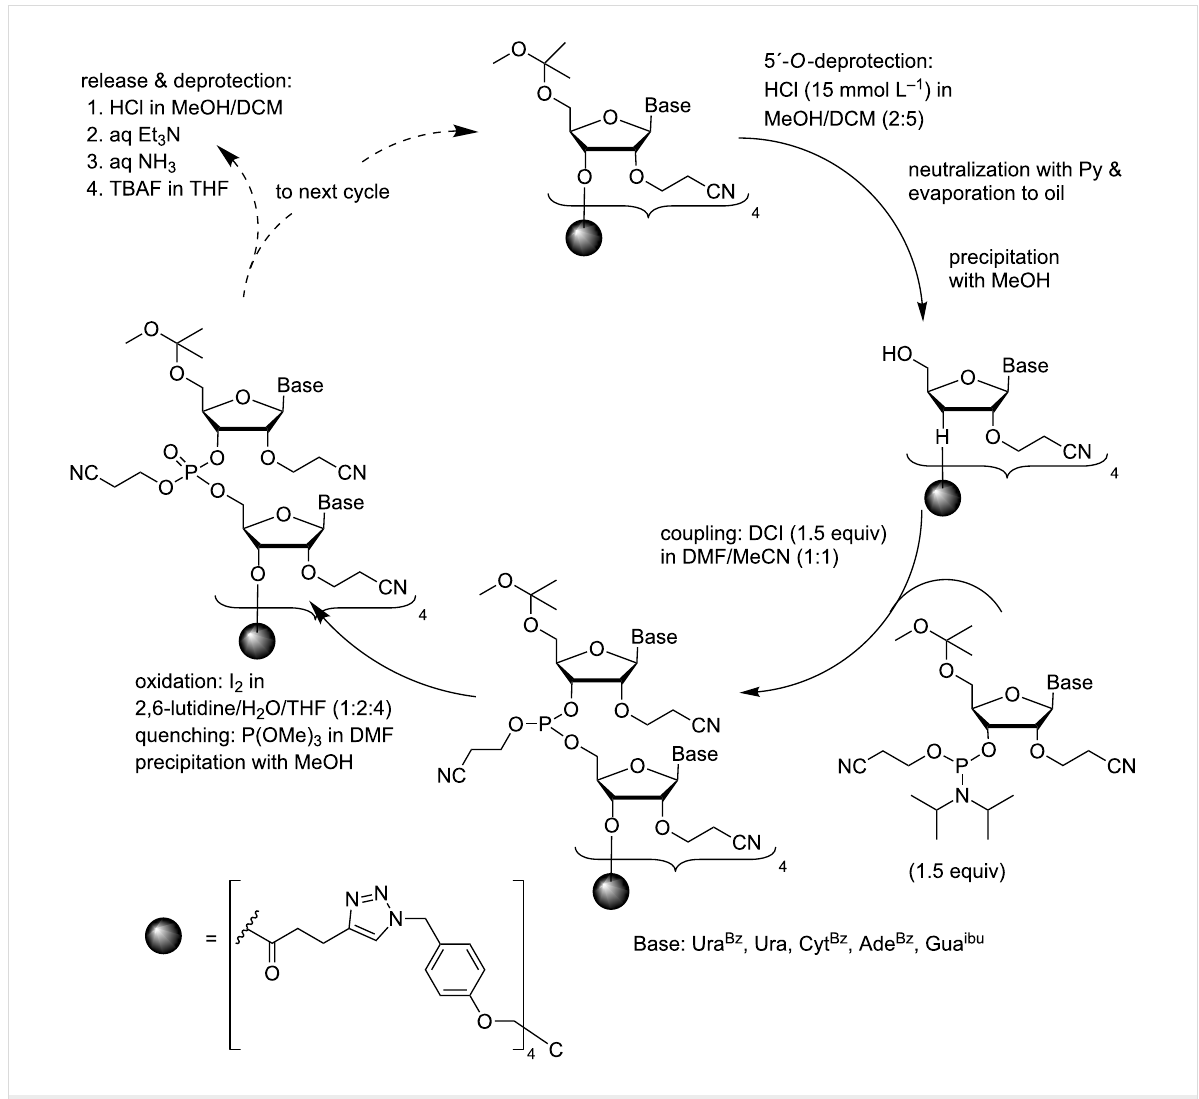
Scheme 10: Synthesis of ORNs by the phosphoramidite chemistry on a precipitative tetrapodal support using 2´- O -(2-cyanoethyl)-5´- O -(1-methoxy-1- methylethyl) protected building blocks [63].